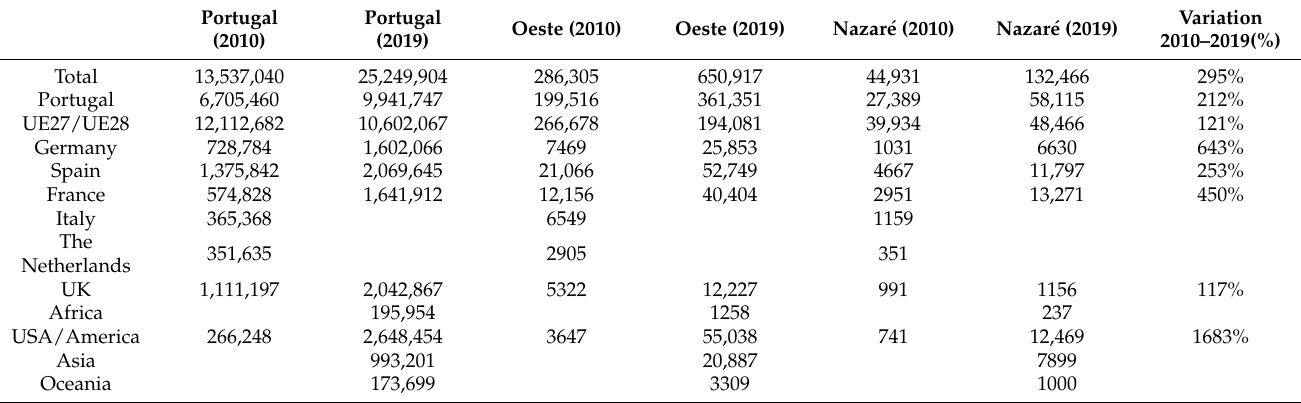
Table 1. Comparative evolution of the number of hotel guests, according to their home countries: in 2010 (before Garret McNamara’s first famous giant wave ride) and 2019 (the last available data without the effect of the COVID-19 pandemic).